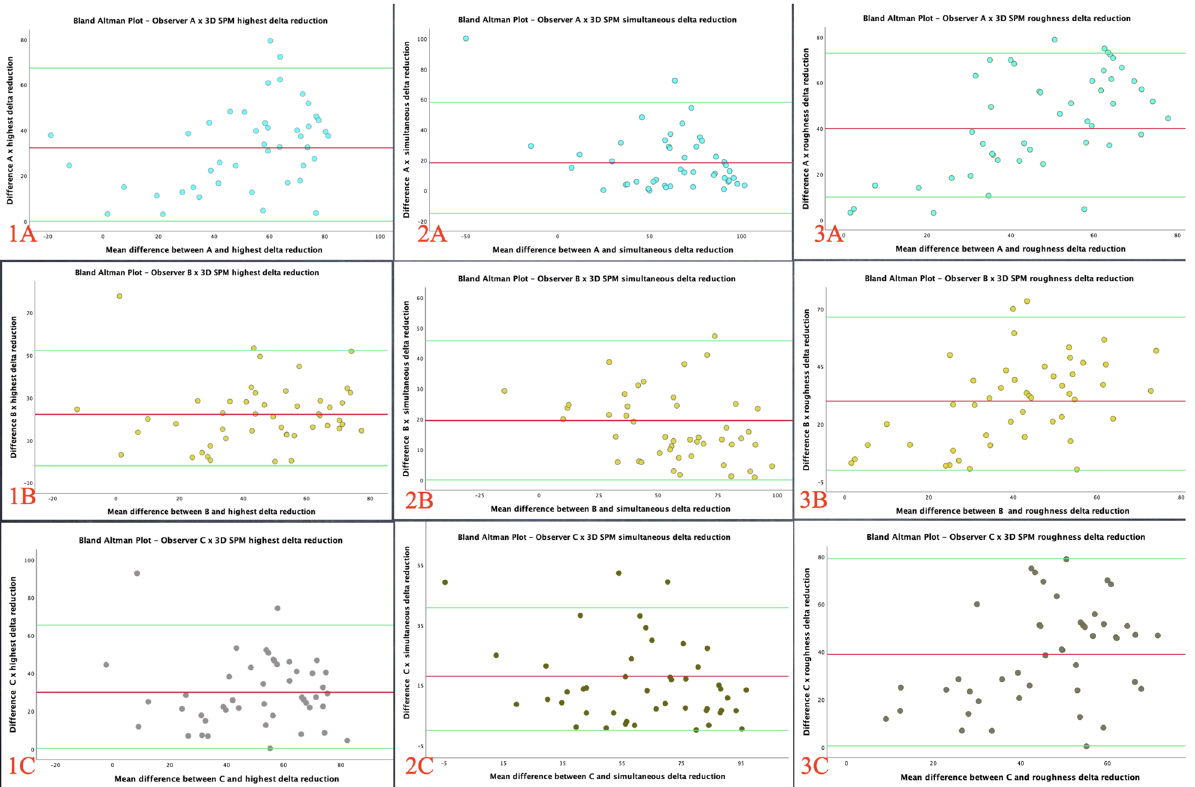
Figure 2. Bland–Altman plots. The letters correspond to observers ( A , B , C ) column 1 is the highest ∂ reduction, column 2 is the simultaneous computation of the two parameters analysed in each group, and column 3 represents the roughness delta reduction. The green lines are the limits of agreement and confidence intervals. The few points outside the limits of agreement confirmed the concordance among observers and the 3D SPM